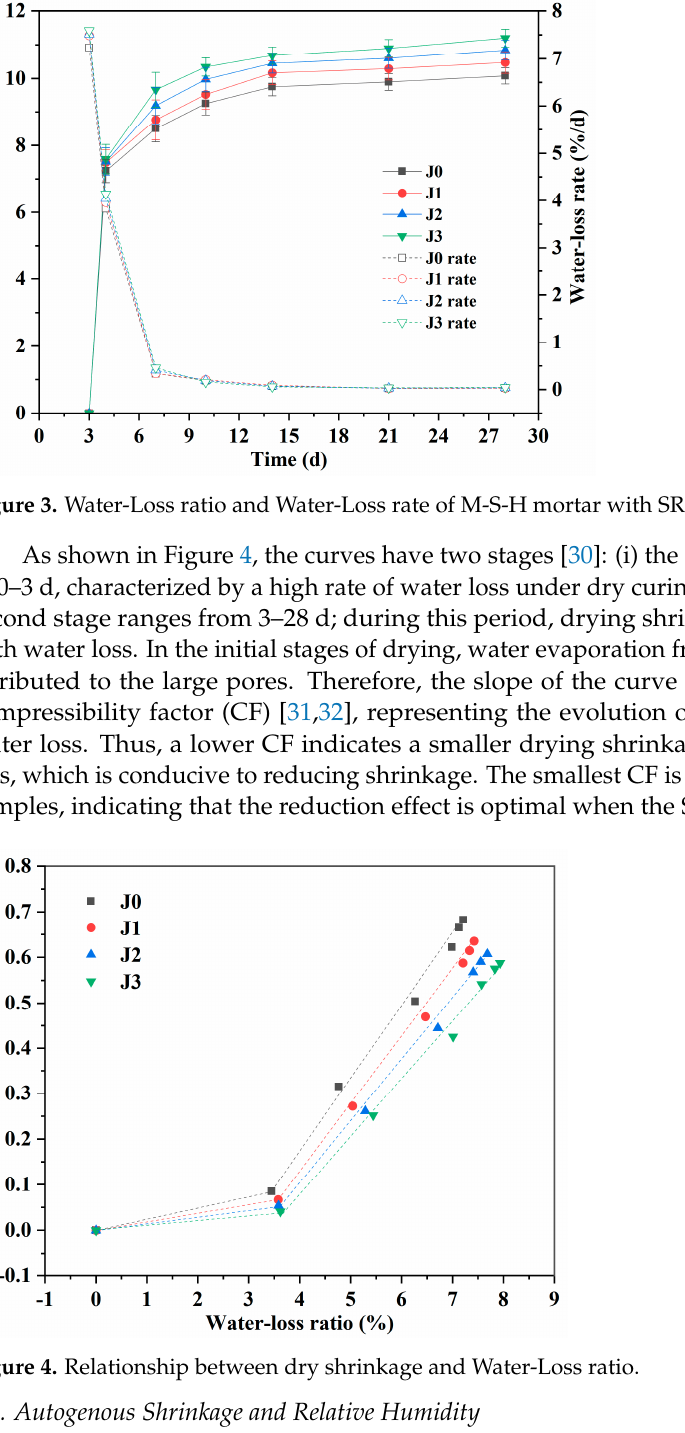
Figure 4. Relationship between dry shrinkage and Water-Loss ratio.